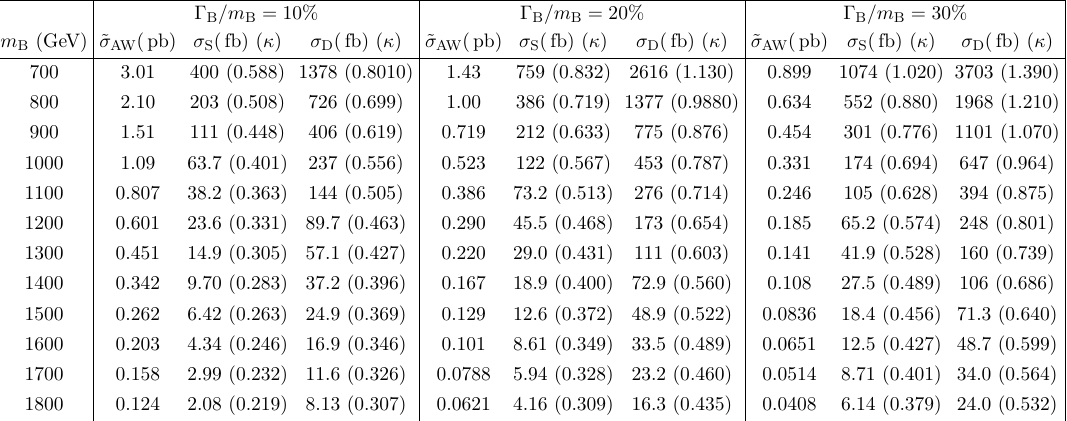
Table 2. Cross sections for pp ! Bbq for three values of the (cid:0) B =m B ratio. The conditions assume that singlets and doublets have (cid:20) W = (cid:20) Z = (cid:20) H (cid:17) (cid:20) , (cid:20) W = 0 and (cid:20) Z = (cid:20) H (cid:17) (cid:20) , respectively. For each (cid:0) B =m B , we provide the values of ~ (cid:27) AW and of the physical cross sections for both the singlet and doublet models, (cid:27) S and (cid:27) D respectively. The uncertainties in the production cross sections correspond to the halving and doubling of the QCD renormalization and factorization scales. The values of (cid:20) are listed in the